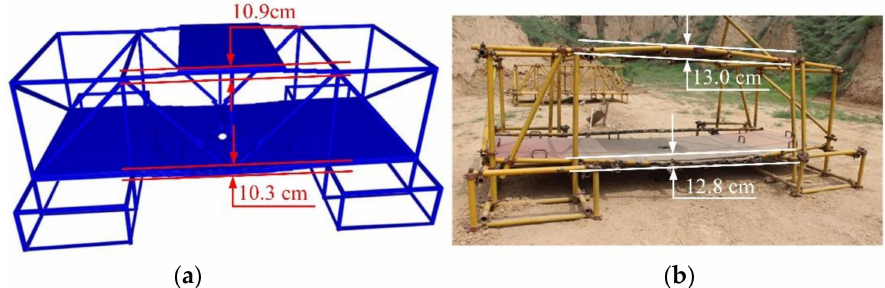
Figure 16. Comparison between the numerical results of the deformation of the composite steel structure and test data. ( a ) Numerical results; ( b ) Test data.